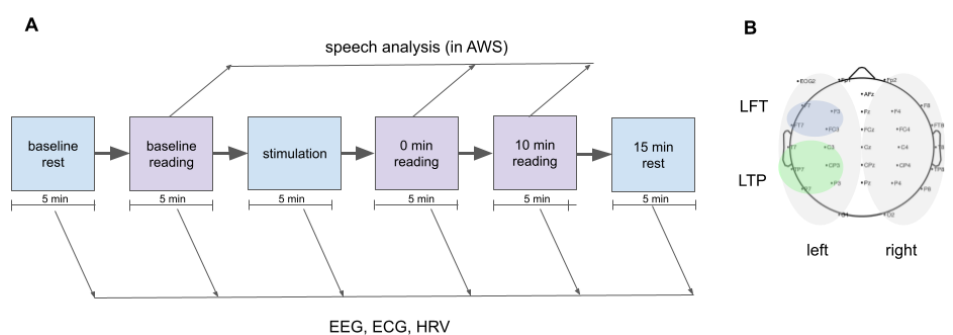
Figure 1. The design of the study. ( A ) Scheme representing the design of the experiments. ( B ) Loca- tion of EEG electrodes (32 in total) used during all experiments with highlighted groups of elec- trodes over the left temporoparietal junction (green on upper topography) and left frontolateral area (blue on upper topography) and groups of electrodes used for the whole-hemisphere analysis (bot- tom topography; blue for the left and green for the right hemisphere). Abbreviations: EEG — electro- encephalographic.